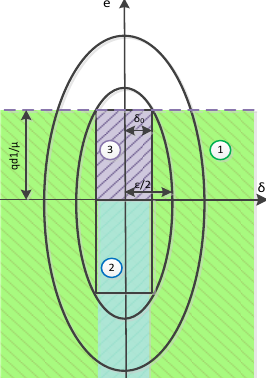
Figure 13. Lyapunov function in term of δ and